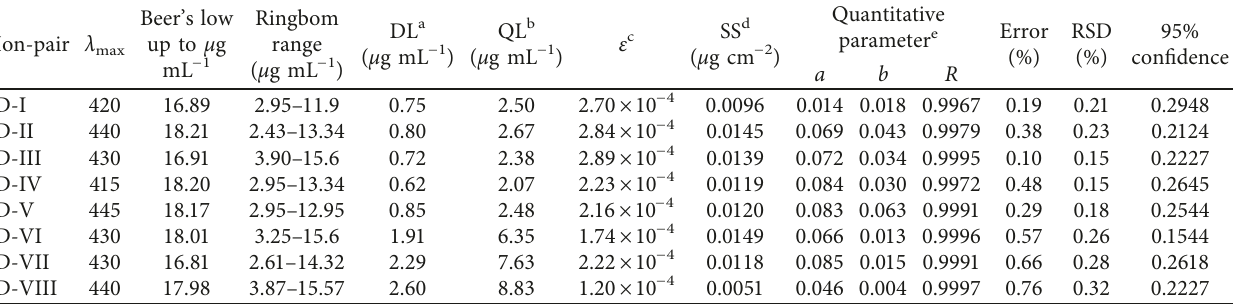
Table 1: Spectral characteristics of the calibration graphs and analytical data in the determination of the studied dug using the ion-associate complex formation